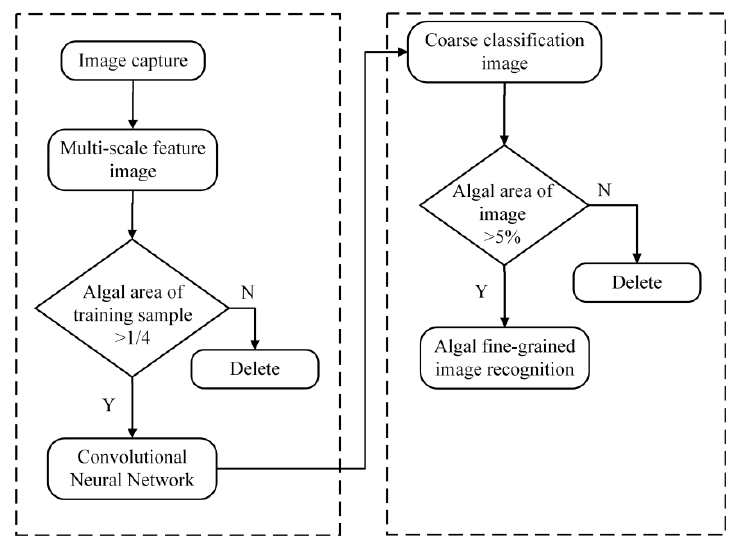
Figure 2. Basic procedure for algal-bloom extraction by using video images.